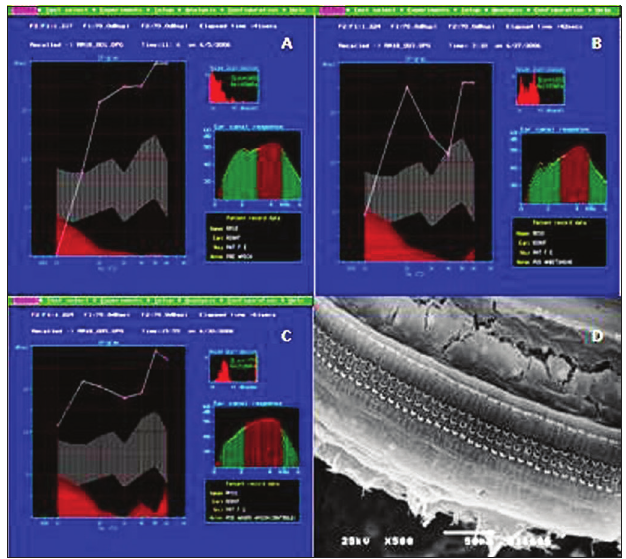
Figura 1. Exemplo de OEA-PD no grupo A. A: pré-exposição, observa-se a manutenção da função auditiva a partir de 1 KHz, com a presença das OEA-PD; B: Após dose não lesiva, mostrando padrão de normalidade com presença das OEA-PD; C: Após dose lesiva, mostrando presença das OEA-PD; D: Exemplo de MEV no grupo controle, mostrando na espira basal Células Ciliadas Externas e Internas normais. Aumento de 500x.